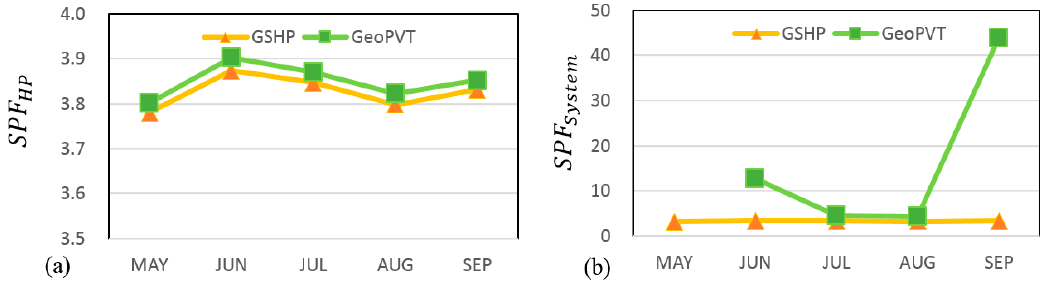
Figure 25. The result of SPF during night time operation in cooling season. ( a ) Heat pump; ( b ) system.